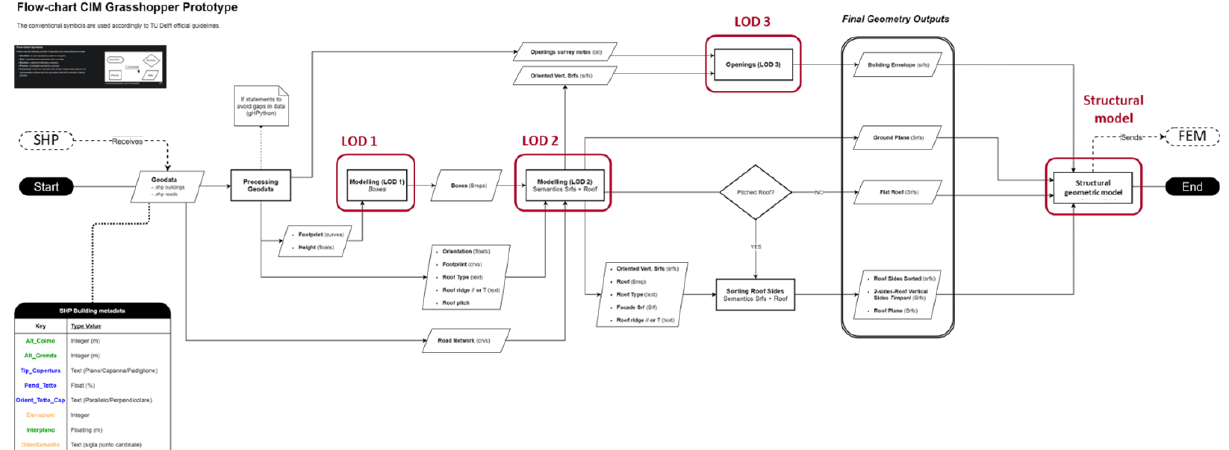
Figure 3 . Flowchart of the VPL code in Grasshopper (TU Delft guidelines) for CIM modeling of the one-storey building